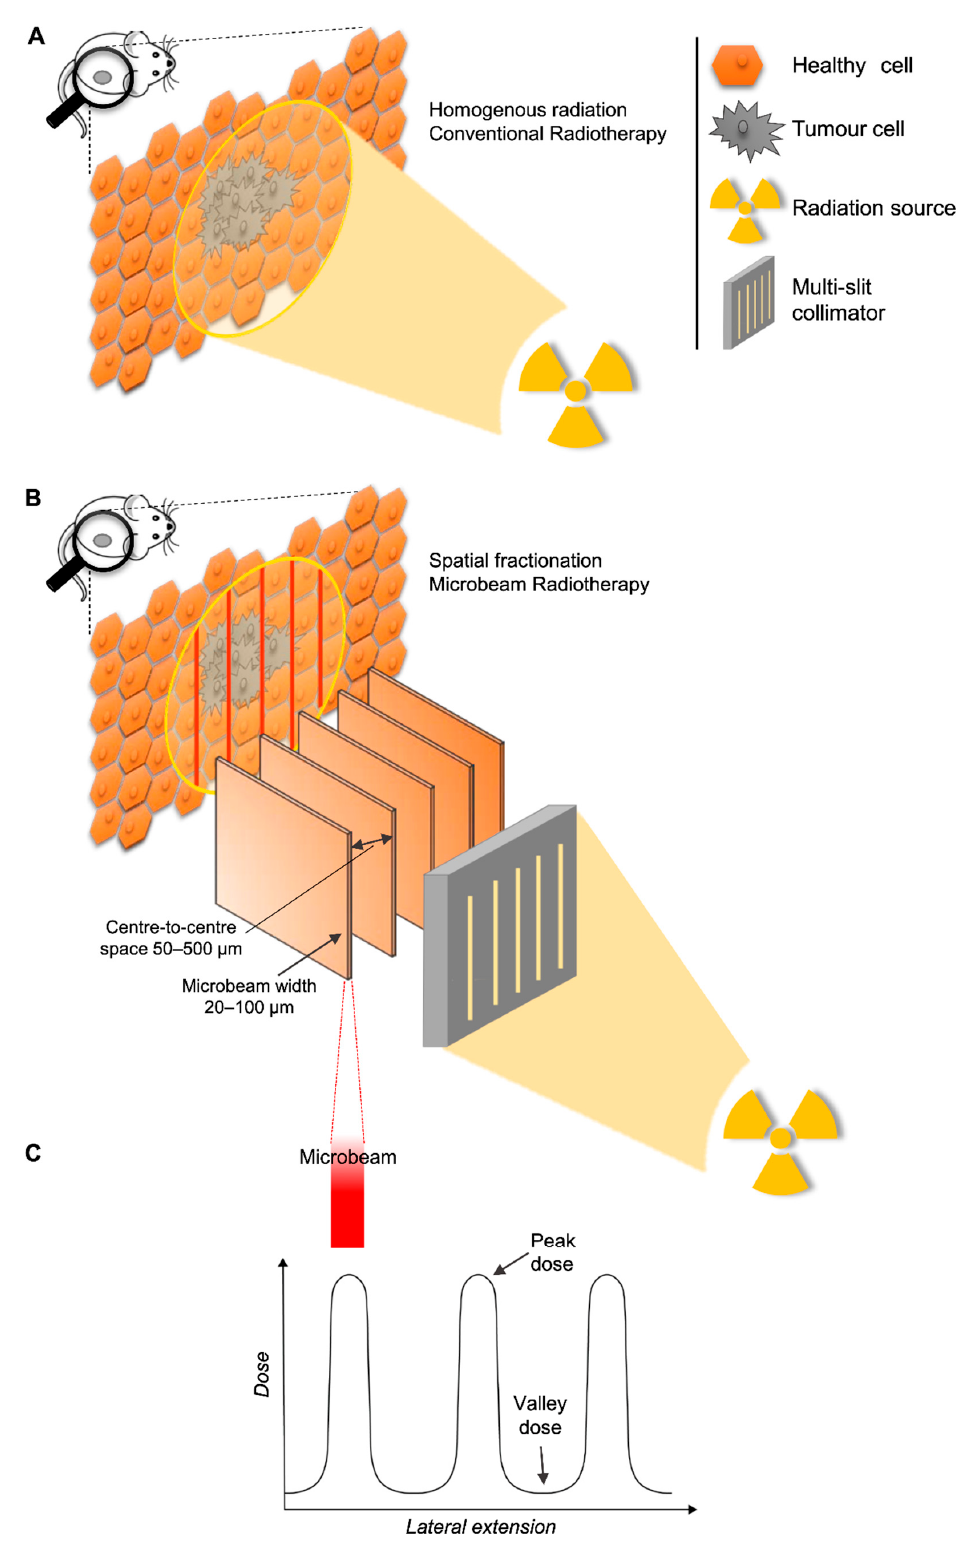
Figure 1. Homogenous radiation vs spatial fractionation. Schematic representation of a homogenous beam of radiation (panel A ) and a MRT array (panel B ) targeting a malignancy. Schematic representation of the microbeams dose distribution (panel C ).